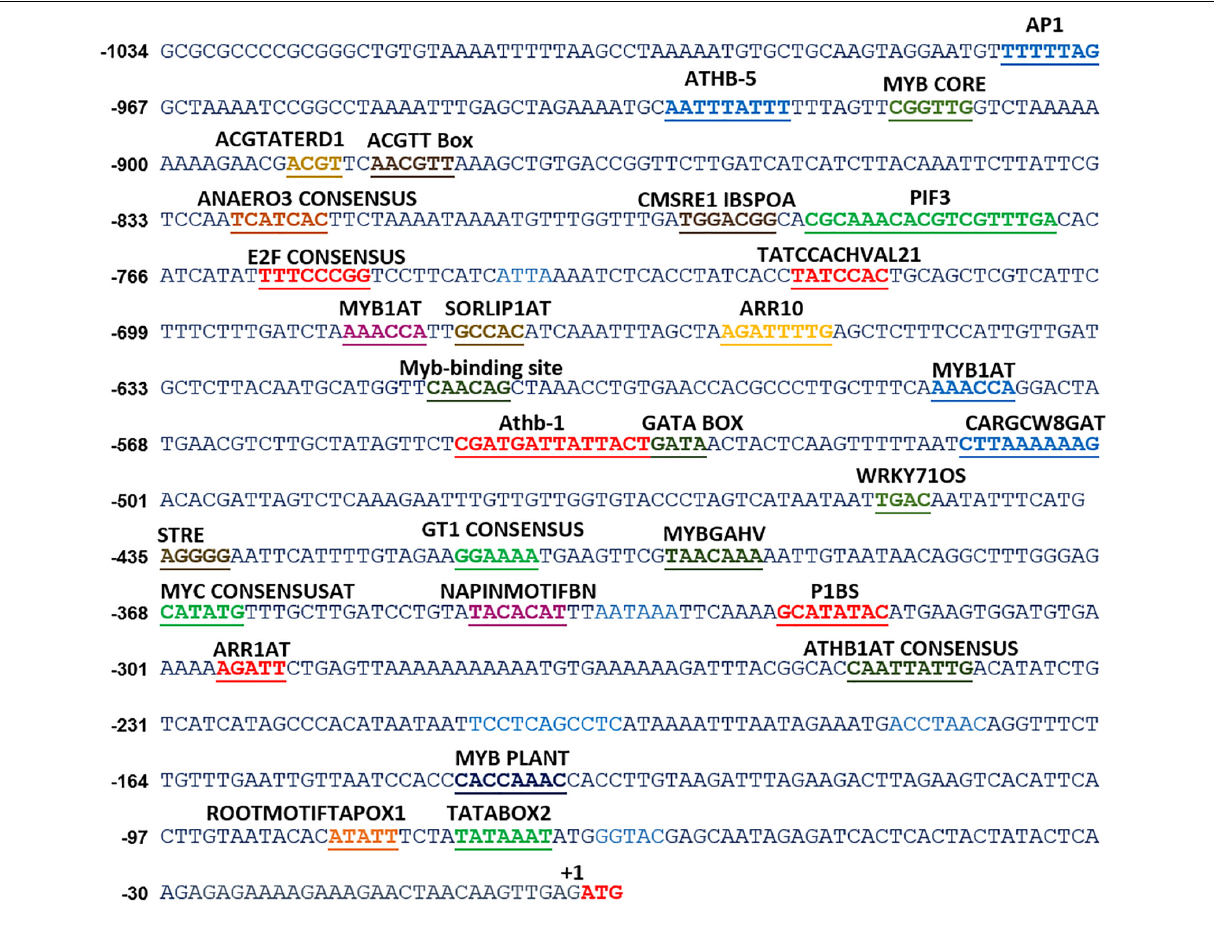
FIGURE 1 | In silico analyses of various cis -acting elements in ShPLR . The analysis indicated the presence of various stress-responsive elements, such as those responding to light, temperature, and dehydration cues. Putative cis -acting regulatory elements are underlined. +1 indicates the translation start